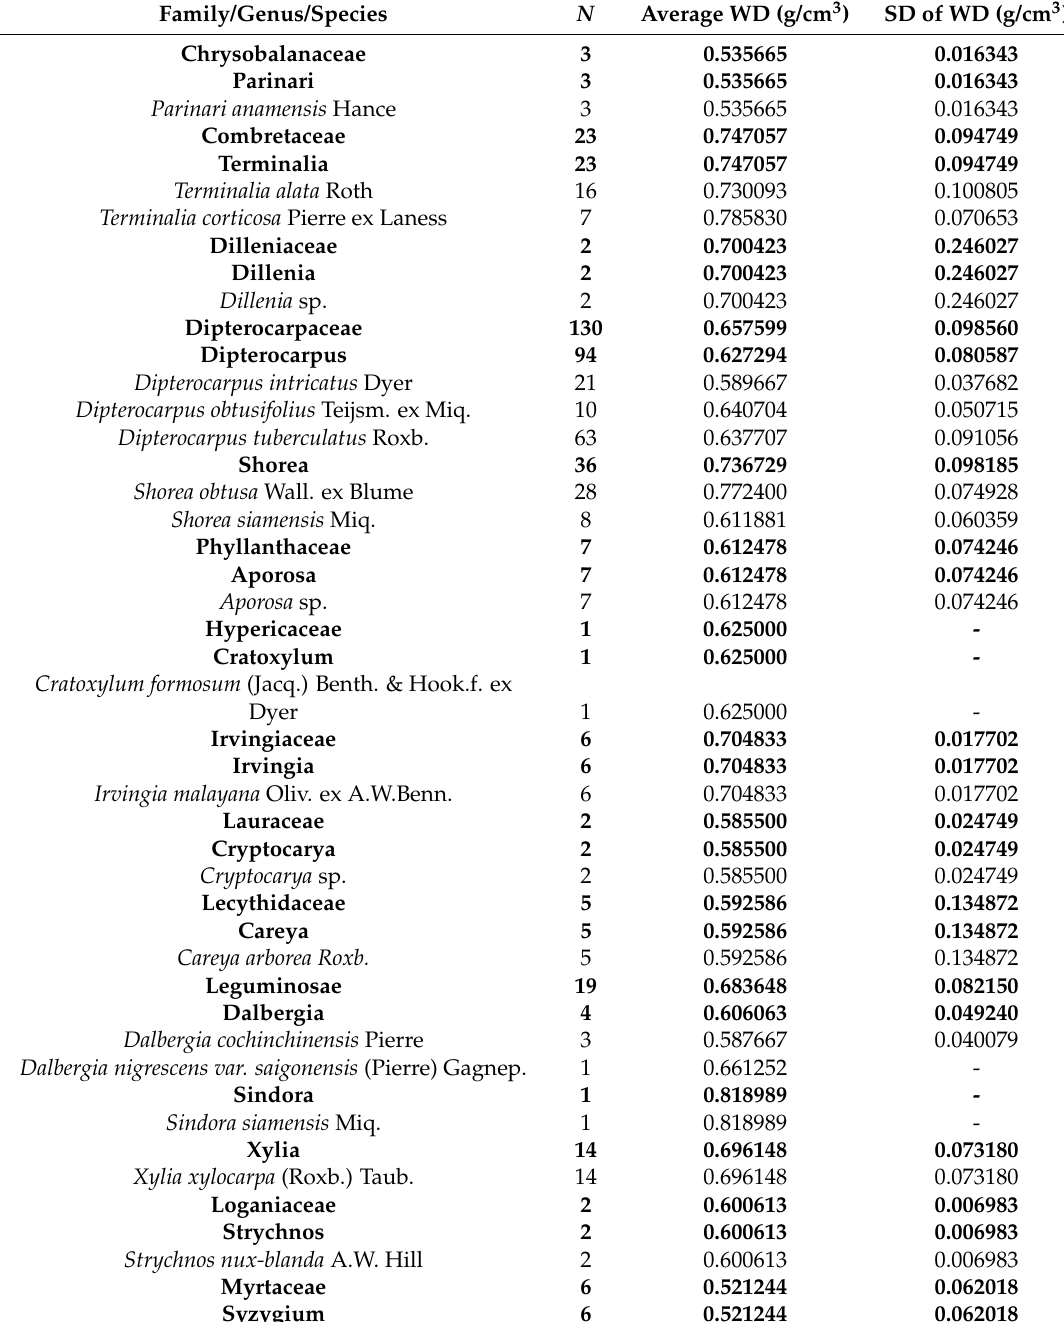
Table 1. Number of destructively sampled trees ( N ), average WD and standard deviation (SD) of WD by family, genus, and species. Family and genus-level averages are in